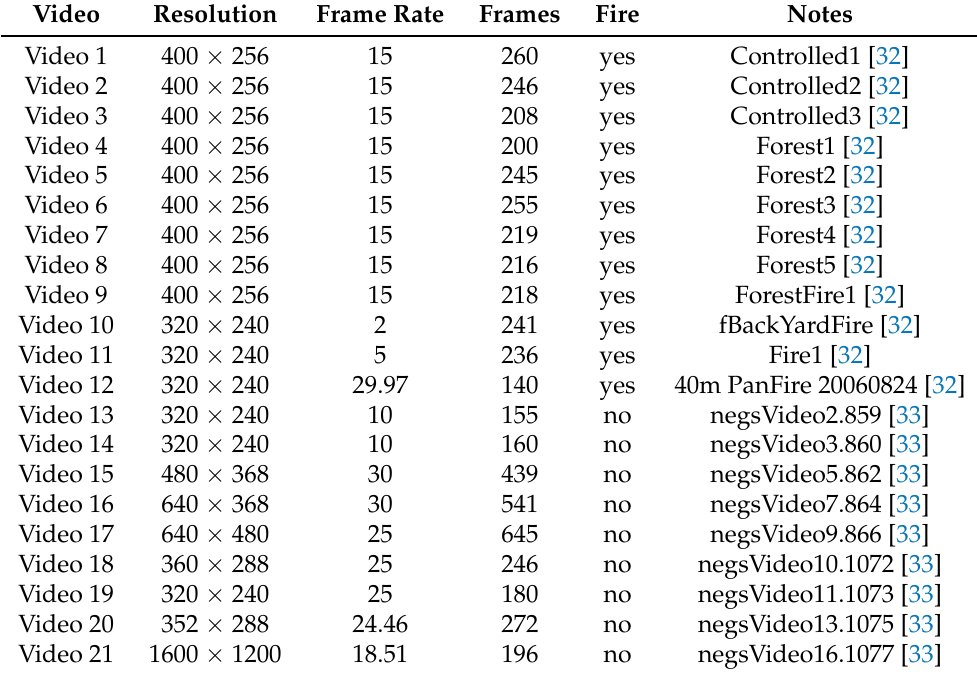
Table 1. Dataset used for evaluation in the